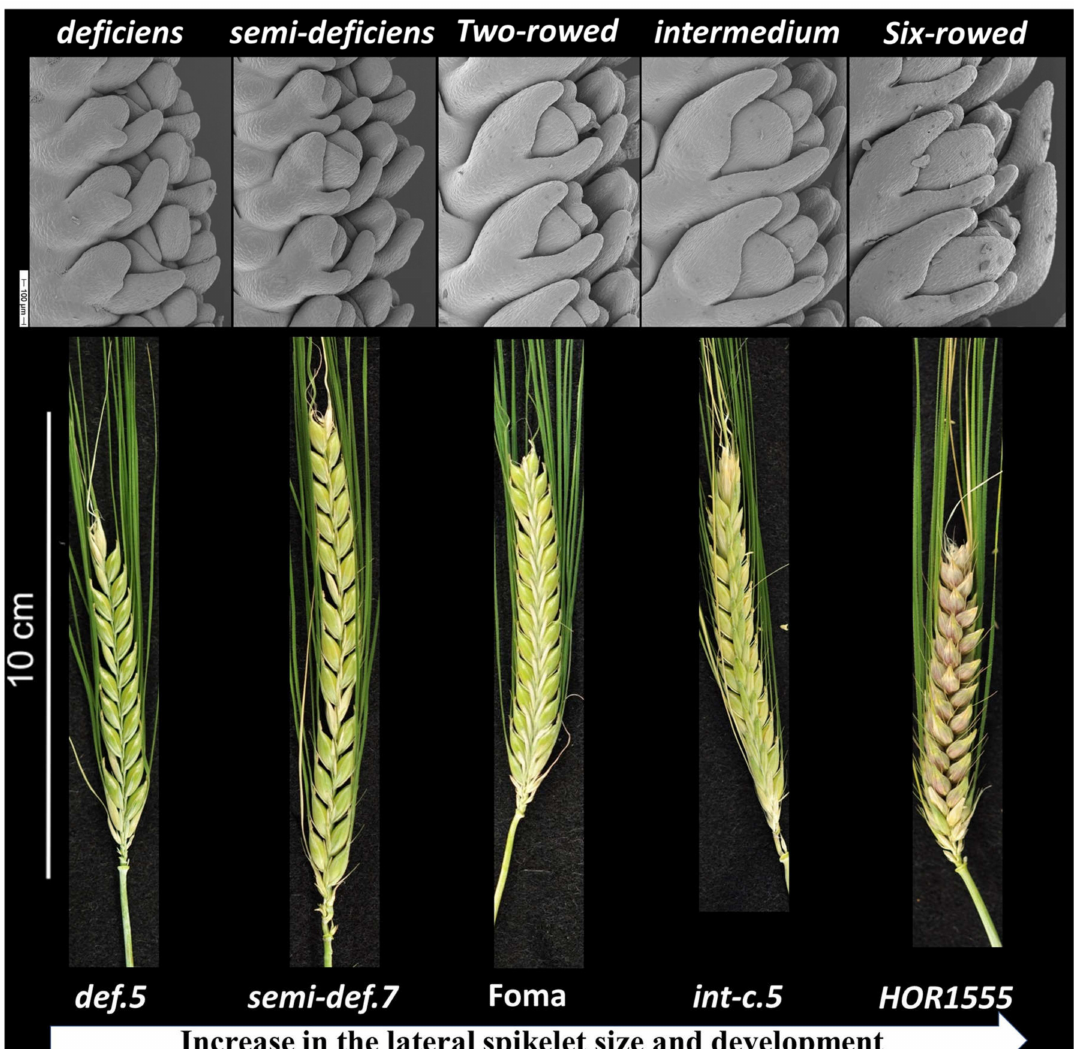
Figure 1. SEM of lateral spikelet development at awn primordia stage and spike form showing increase in the lateral spikelet size and development from left to right in the lines; deficiens phenotype ( cv. Kristina, int-h.43, int-i39, def.5, def.6, semi-def.1, semi-def.8 ), semi-deficiens phenotype ( semi-def.4, semi-def.5 and semi-def.7 ), two-rowed phenotype ( cvs. Bonus, Bowman and Foma), intermedium phenotype (mutants int-a.1, int-c.5, int-e.20, int-e.4, int-f.19, int-l.81, int-m. 85, HOR6211, HOR10166 and HOR6407) and Six-rowed phenotype ( hex-v.3, HOR1555, HOR7191 and